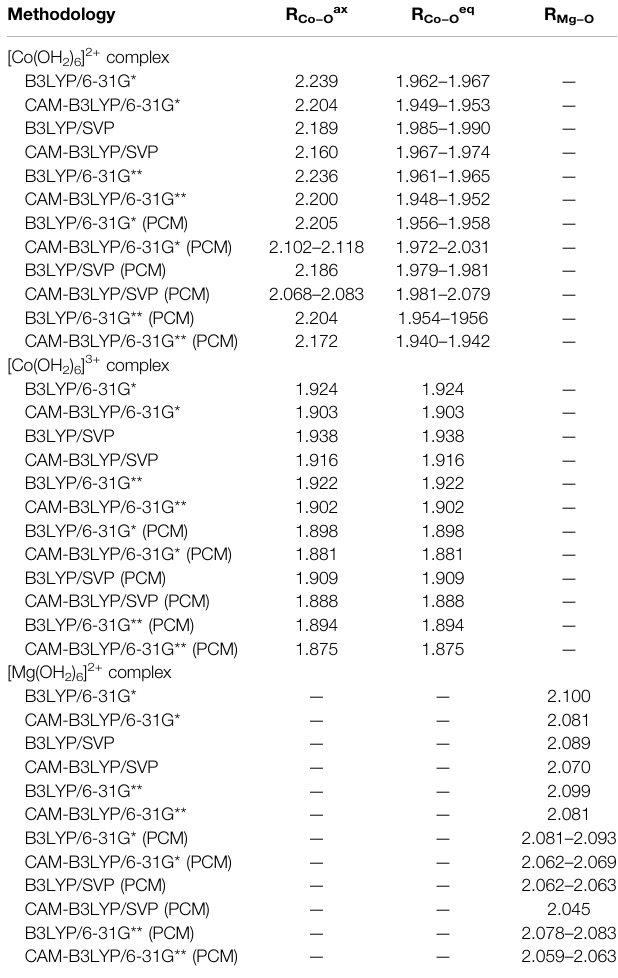
TABLE 1 | Axial and equatorial bond lengths in Å for the hexaaqua complexes discussed in this study.